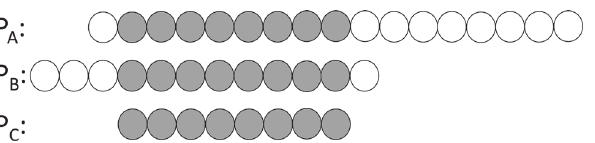
Fig 2. A simple diagram of a nested AMP family. This nested family has three AMPs: P A , P B , and P C . Each circle represents an amino acid. The circles in gray are the critical regions of the family, which are the overlapping residues shared by all the family members; those in white are the non-critical regions. Note: here a family has at least two members and one member with at least seven amino acids long would map to the critical region